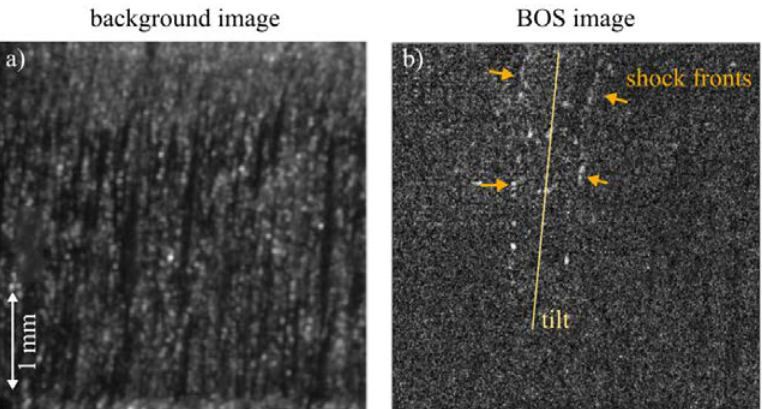
Figure 10. BOS imaging of the gas jet in a conventional laser cutting machine. ( a ) A previously cut kerf is used as a background image. ( b ) The gas jet is imaged afterwards with a frame rate of 37,000 fps and an illumination time of 0.5 µs.